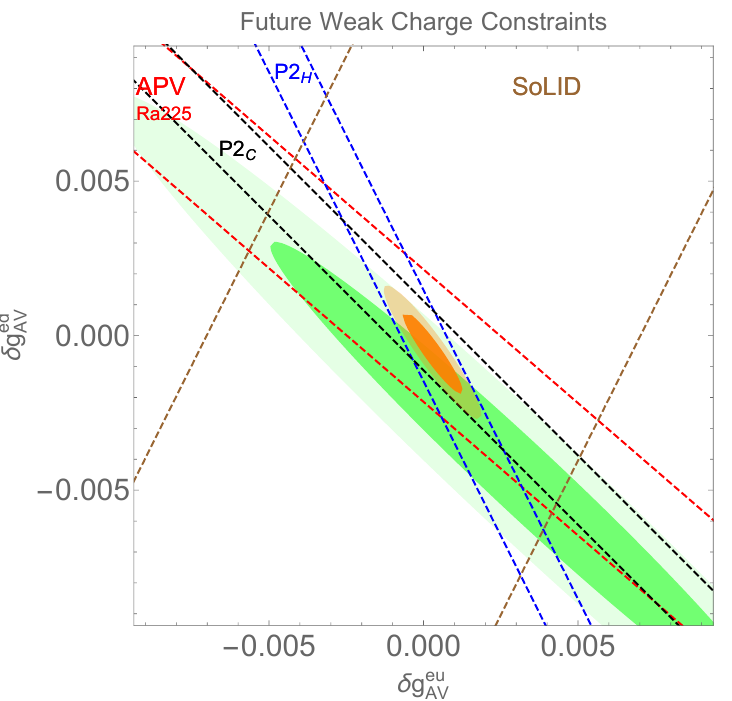
Figure 3 . Present (green) and projected (orange) 68% and 95 % CL constraints on the wEFT parameters g ed and g ed . The dashed lines show the projected 95 % CL constraints separately from AV AV P2 with the hydrogen (blue) and carbon (black) target, SoLID (brown), and APV in 225 Ra (red).